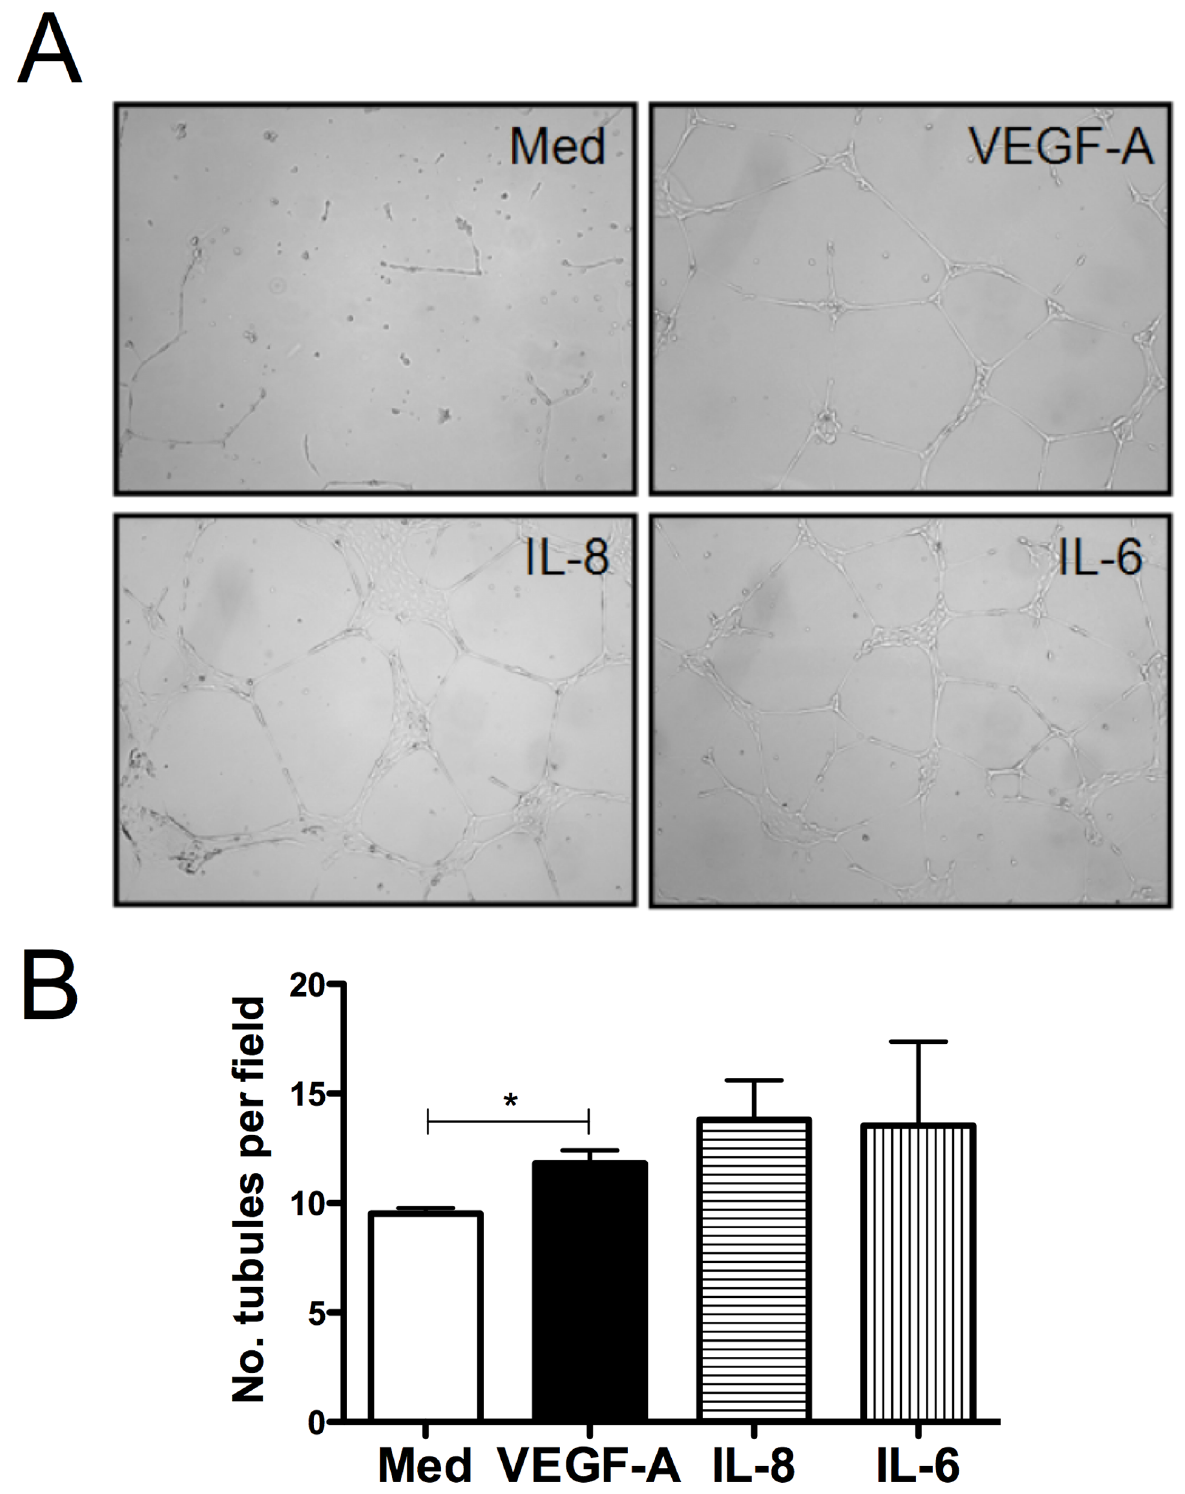
Figure 3. Filarial ES-induced lymphangiogenic mediators induce LEC tubule formation invitro . LECs were grown on Matrigel in the presence or absence of IL-8, IL-6 or VEGF-A and lymphatic networks were photographed (A). (B) The number of tubules was quantified using image analysis software. The data represented here are the means + SEM of one experiment representative of 4 independent experiments performed in triplicate.